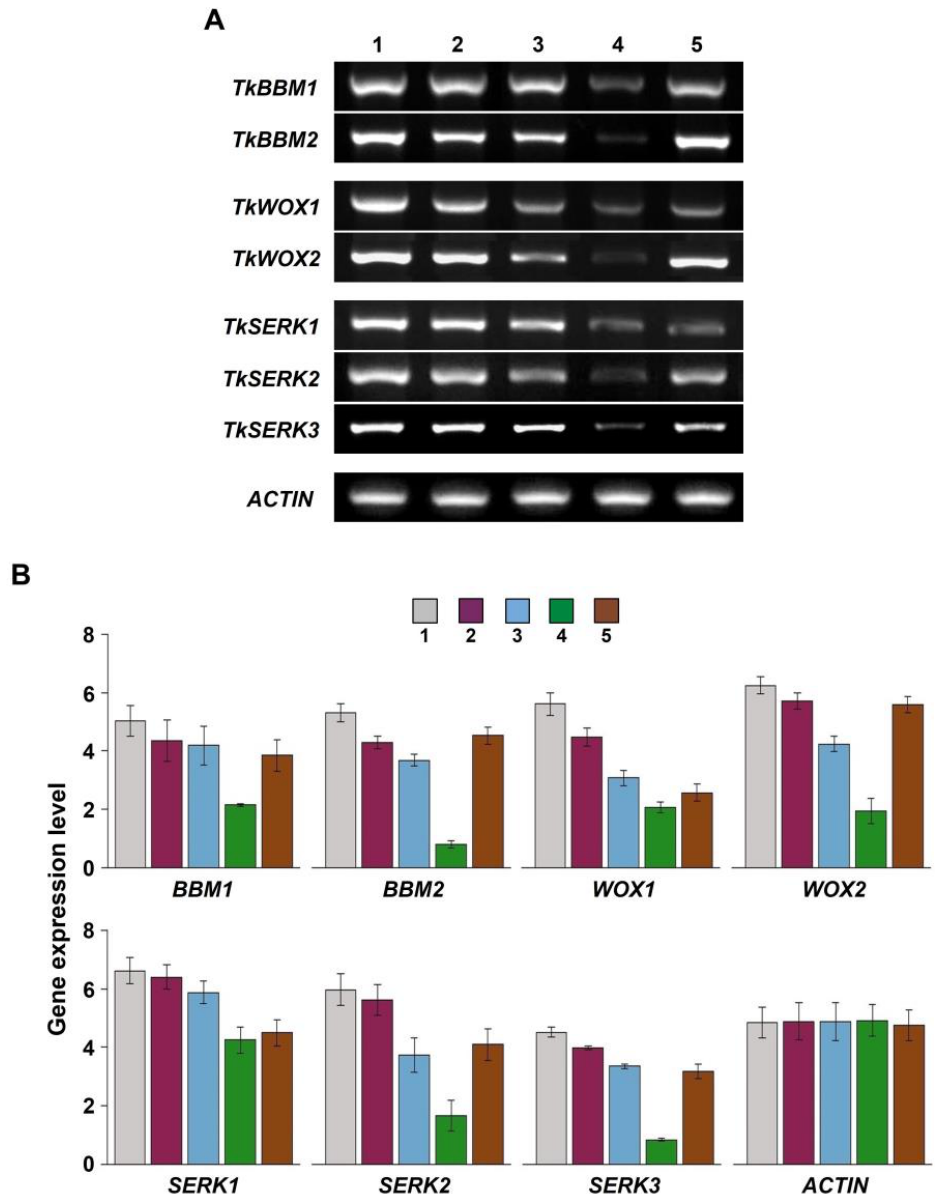
Figure 7. Characteristic stages of somatic development of T . koraiensis embryos and seedling. ( A ) Proembryonic masses (PEMs) on maturation medium. Scale bar: 5 mm. ( B ) Early embryo on matu- ration medium after 10 days. Scale bar: 1 mm. ( C ) Fully mature cotyledonary embryo on maturation medium after 30 days. Scale bar: 2 mm. ( D ) Somatic seedling with the first true needles emerging and a taproot on germination medium after 60 days. Scale bar: 1 mm.